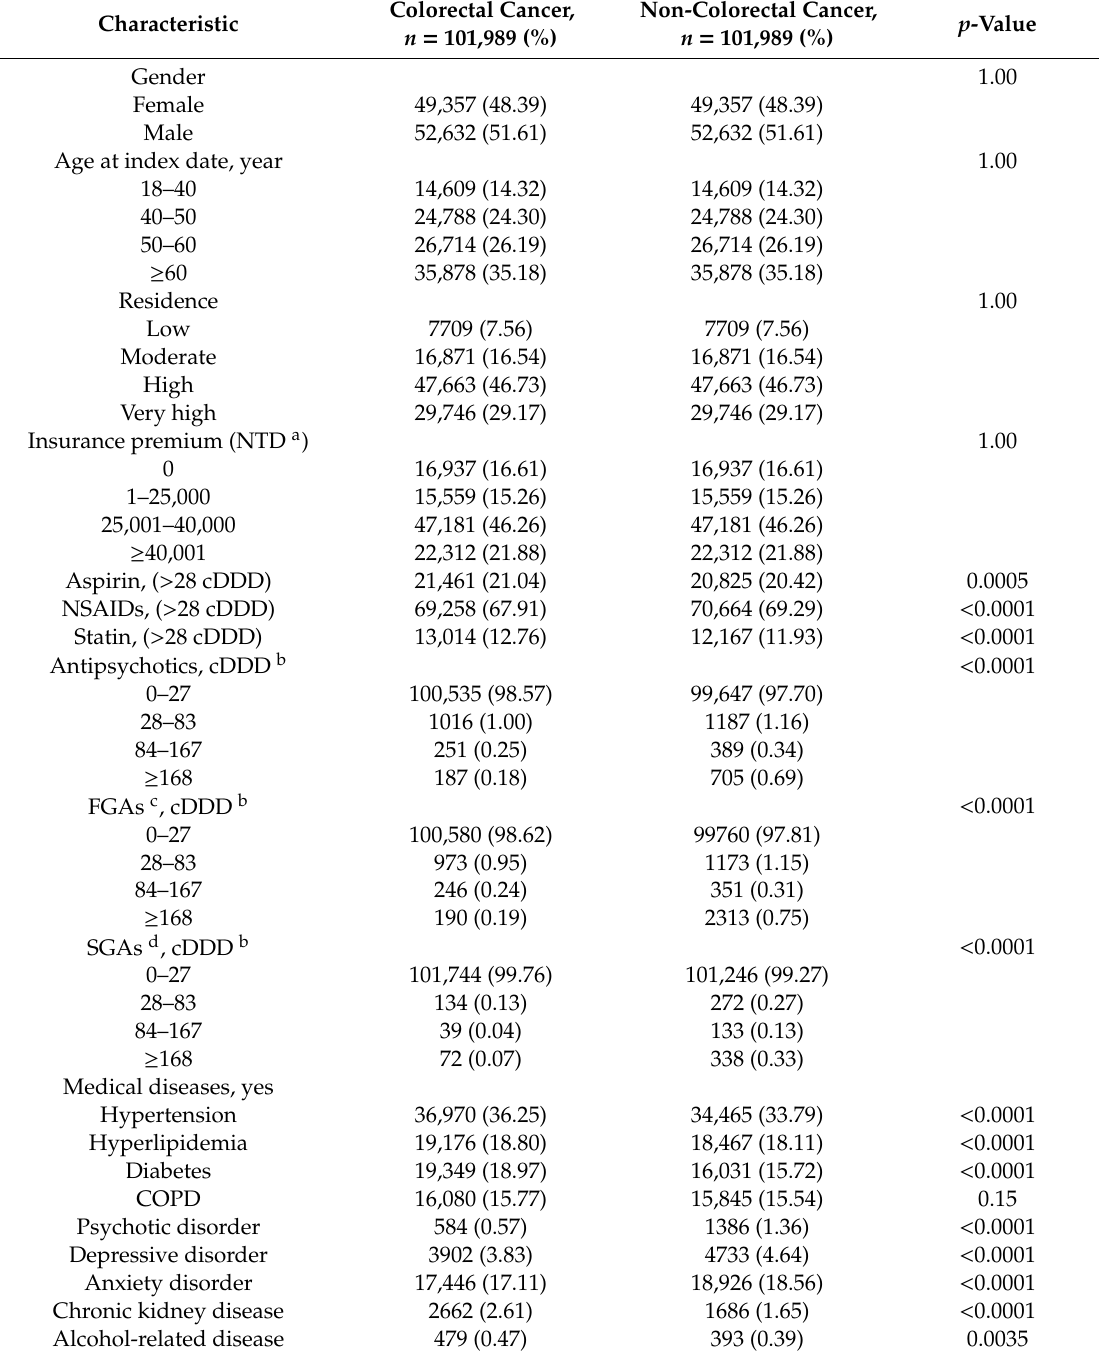
Table 1. Demographics and clinical characteristics of patients with colorectal cancer and those with noncolorectal cancer after exact matching in Taiwan between 1997 and